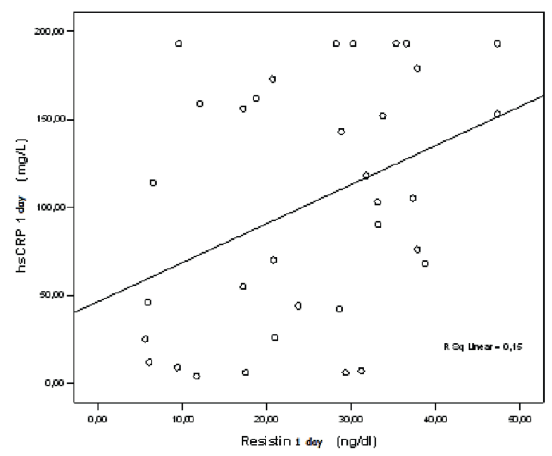
Figure 1. The linear regression between the serum resistin and hsCRP levels on the 1st day. (y=2.220x + 46.28